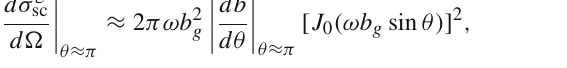
Fig. 2 Geodesics being bent in the parametrized black hole space- time(3),fordifferentvaluesofthedeformationparameter η .Theimpact parameter is chosen to be b = 5 . 5 M . We also show the Schwarzschild case ( η/ M 3 = 0 . 0)